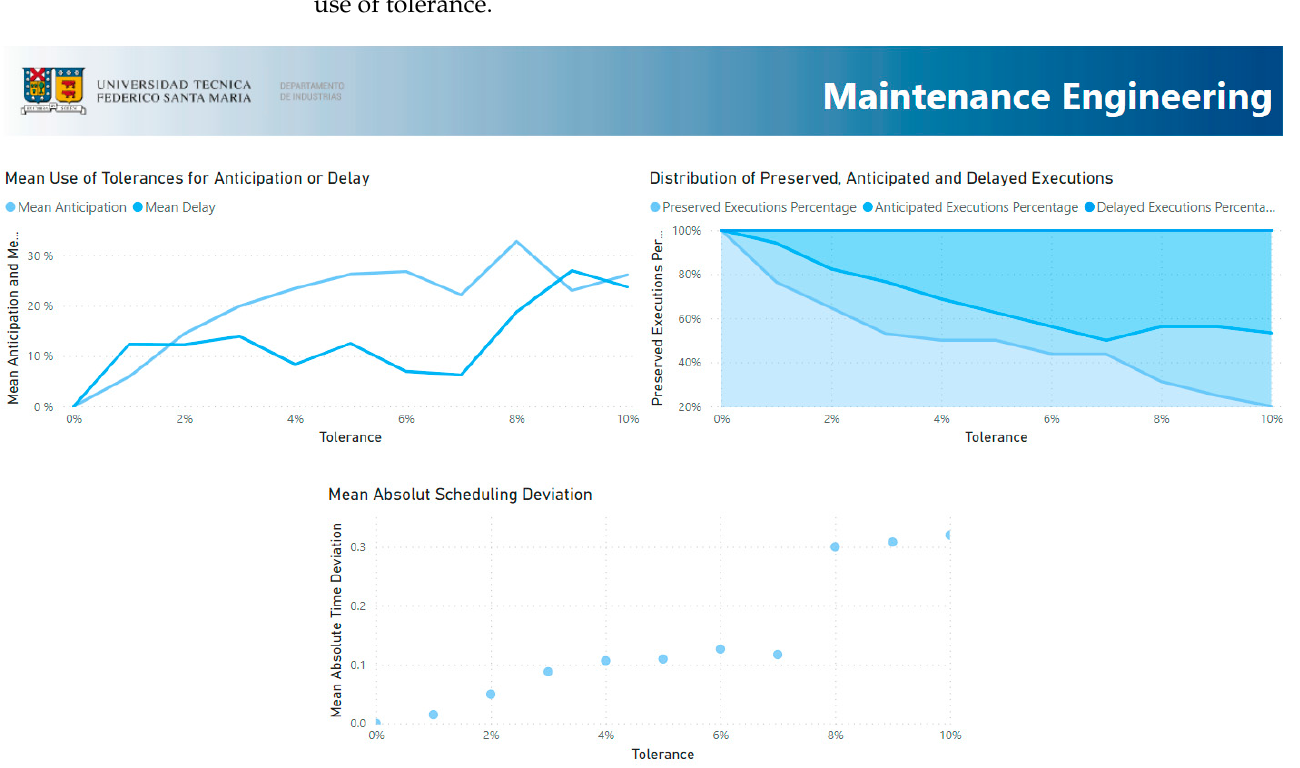
Figure 6. Maintenance management section.